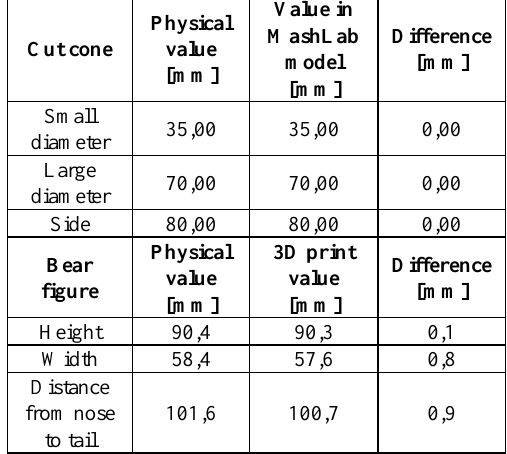
Figure 1. FabScan scanner